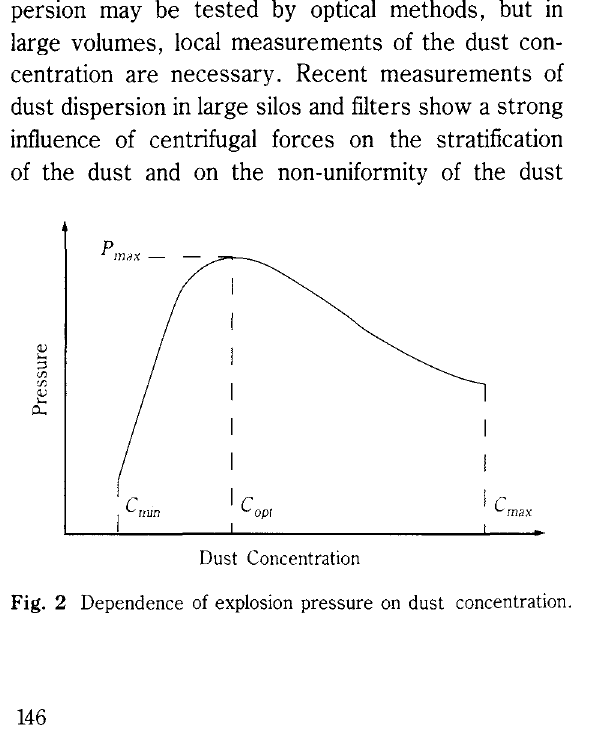
Fig. 2 Dependence of explosion pressure on dust